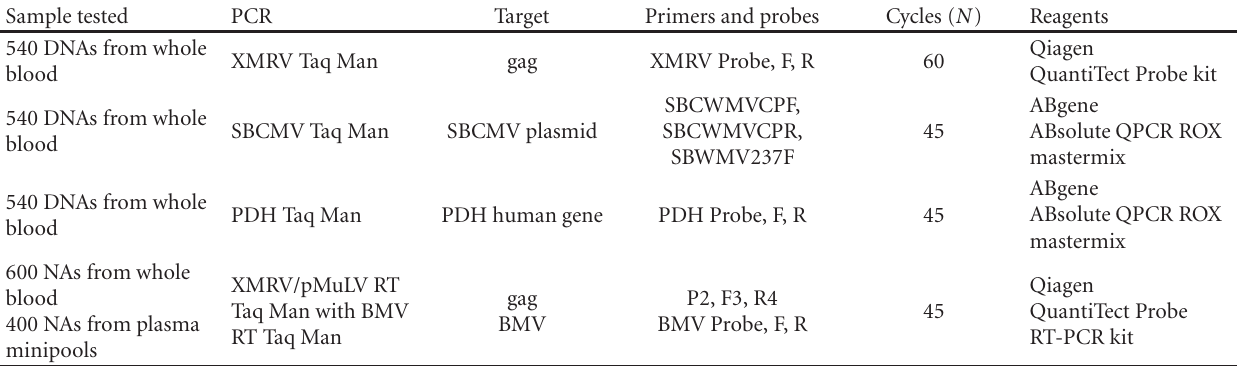
Table 1: Details of PCRs used to test blood